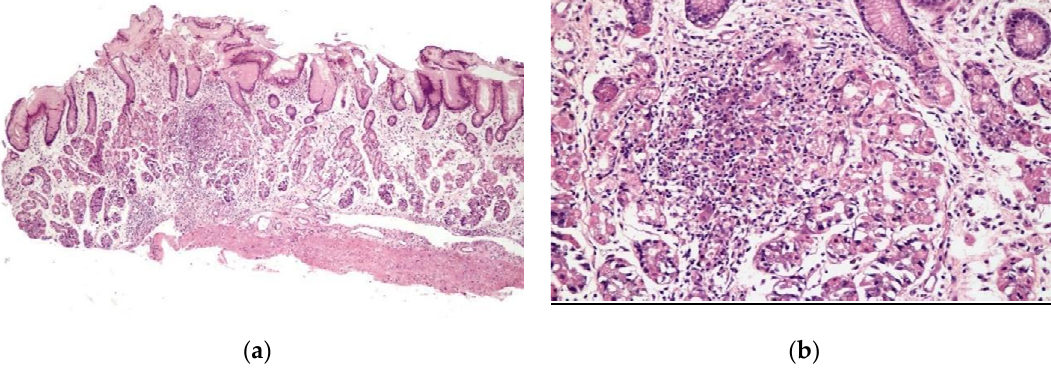
Figure 2. Focal enhanced gastritis: mononuclear inflammatory infiltrate associated with focal destruction of glands. Lesion intensity contrasts with slight inflammatory infiltrate in the remaining lamina propria. ( a ) H&E × 40; and ( b ) H&E × 100.